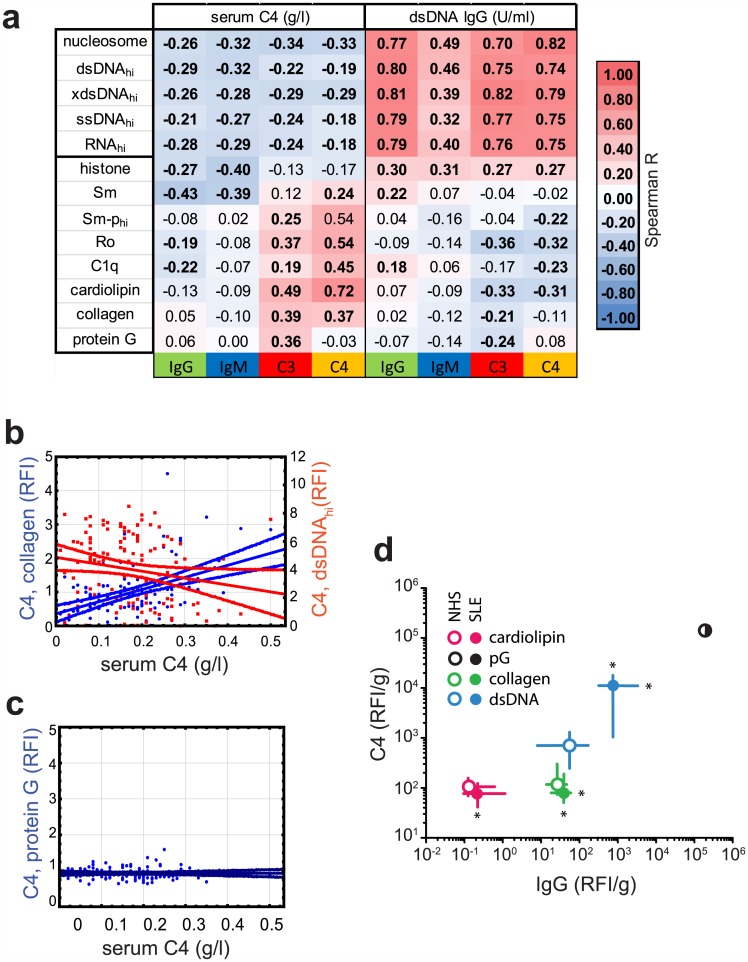
Opposite complement activating properties of biochemically different antigens in SLE.The PECS SLE cohort with available serum complement concentrations (n = 124) was analyzed for associations between serum protein levels and on-chip antigen binding of immunoglobulin and complement proteins. a Spearman rank-correlations of serum C4 concentrations, dsDNA IgG reactivity with various microarray derived binding data. Values indicate r, bold fonts highlight significant correlations (p<0.05). b Comparative C4 deposition on dsDNA and collagen as a function of serum C4 concentrations. Linear regression fits with 95% confidence intervals are shown. c Complement C4 deposition initiated by superantigen protein G as a function of serum C4 concentration. d Comparative C4 deposition and IgG binding on various antigens on a mass basis in healthy and SLE serum samples. Asterisks indicate direction and significance (p<0.05) of changes in the SLE versus NHS group. pG, Staphylococcal protein G.